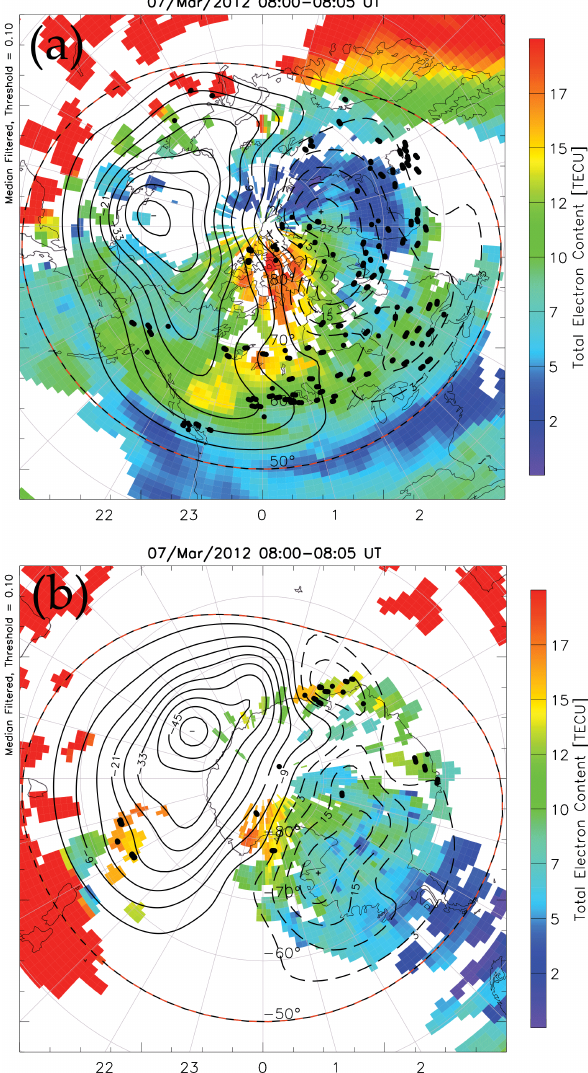
Figure 10. SuperDARN convection and potential maps in the (a) Northern and (b) Southern Hemisphere on 7 March. The IPPs with σ (cid:56) >0.1rad or sDPR>2mms − 1 are superposed as black dots.